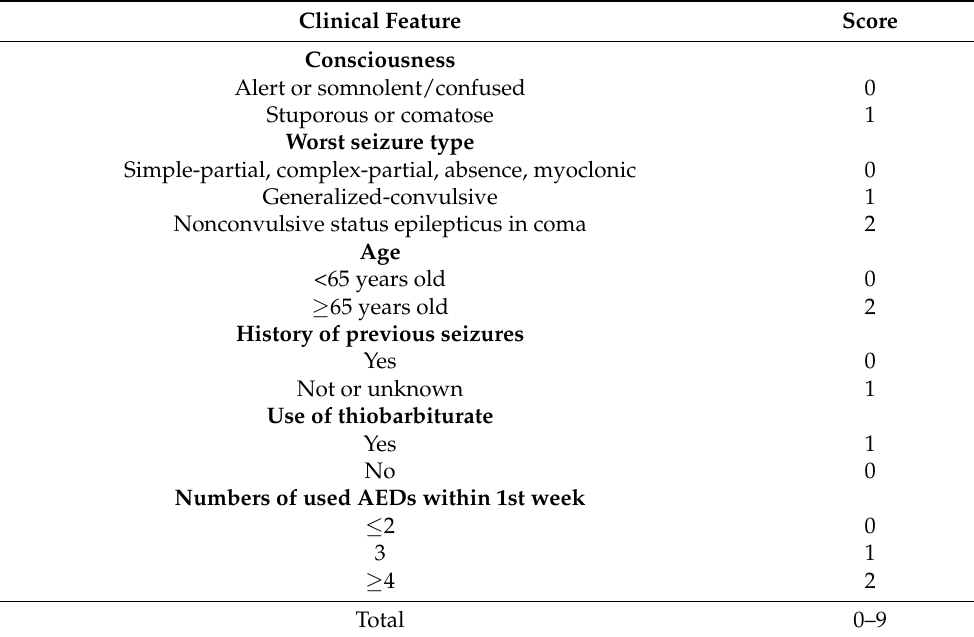
Table 2. Components of Newly Modified STESS